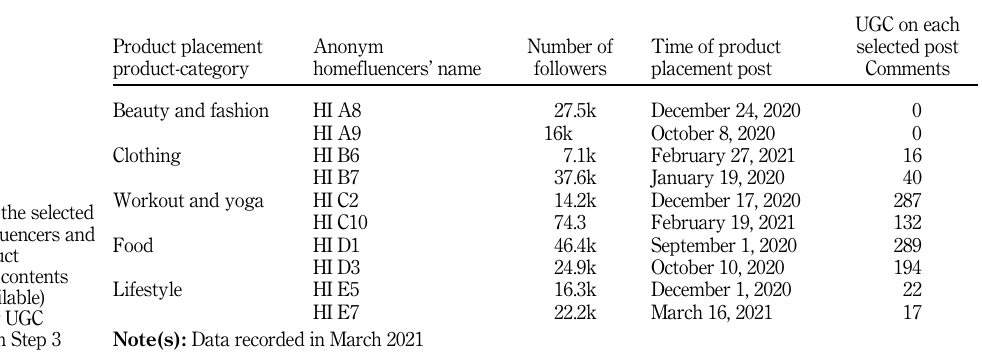
Table 2. Profiles of the selected ten homefluencers and their product placement contents (when available) generating UGC analyzed in Step